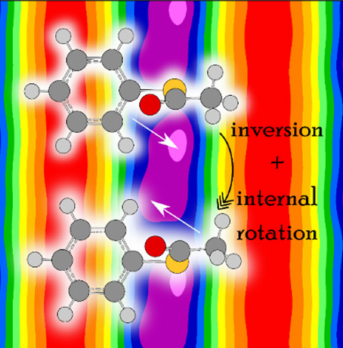
Figure 21. Front layer: View onto the phenyl ring of phenyl thioacetate, showing that: (i) The phenyl ring is almost perpendicular to the C–(C=O)–S plane, and (ii) there are two equivalent structures, corresponding to the inversion tunneling of the phenyl ring (or the thioacetyl group). Back layer: The potential energy surface of phenyl thioacetate calculated at the MP2/6-311++G(d,p) level of theory. The minima are extremely flat and asymmetric